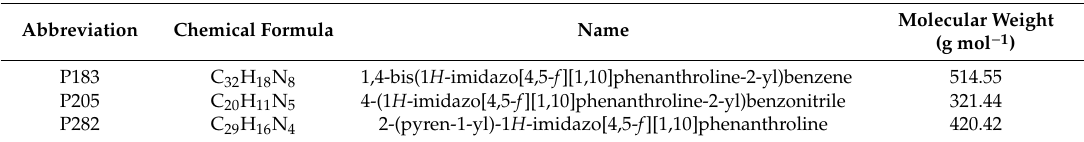
Table 1. The molecular structure of the materials used in this study as PLDS liquid optical